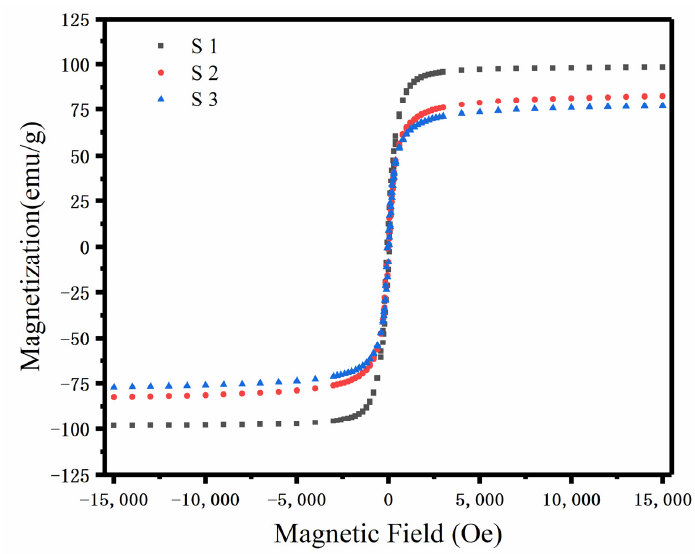
Figure 6. Magnetic field-dependent magnetization curves of S1, S2, and S3. The dielectric loss angle tangent ( tan𝛿 (cid:3032) ) and the magnetic loss angle tangent ( tan𝛿 (cid:3040) ) can reflect the dielectric loss and magnetic loss per unit volume of the material, respec- tively, and they are calculated by the following equations: 𝑡𝑎𝑛 𝛿 (cid:3032) = 𝜀 ″ 𝜀 ′